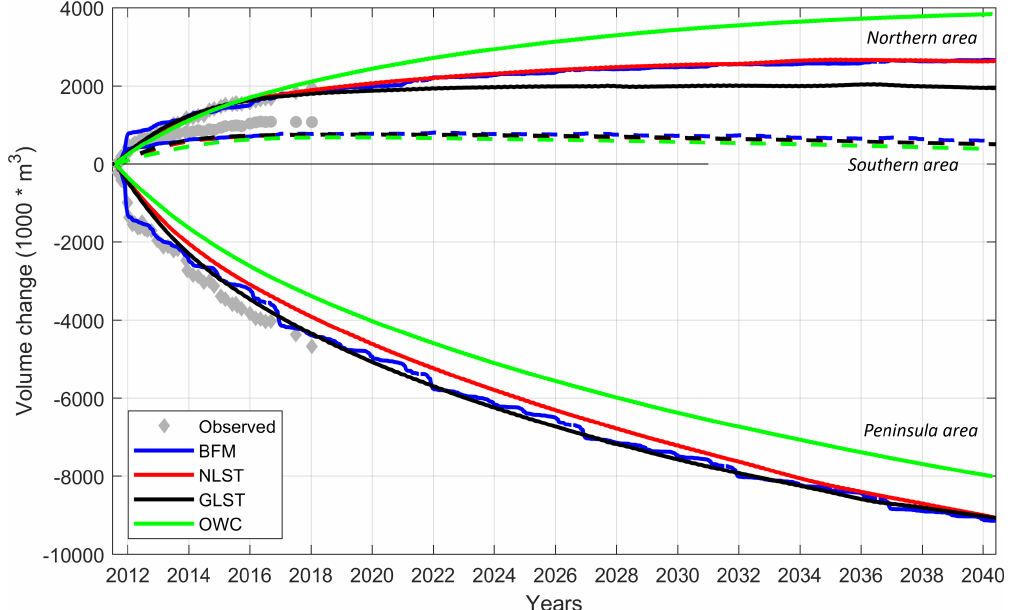
Figure 14. Volume changes in the period 2011–2040 for the four considered acceleration techniques for the three control areas (see Figure